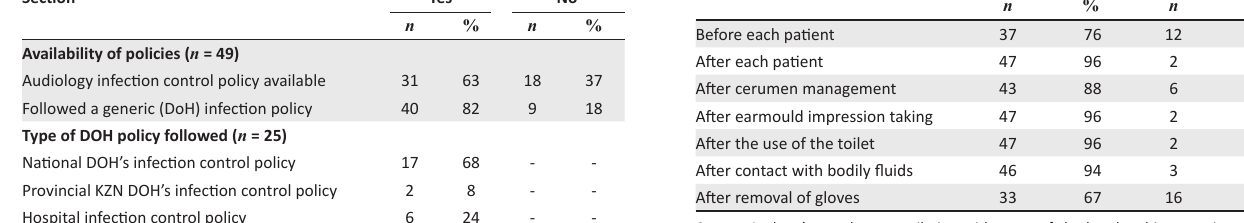
TABLE 2: Summary of the infection prevention and control policies used by the participants. Section